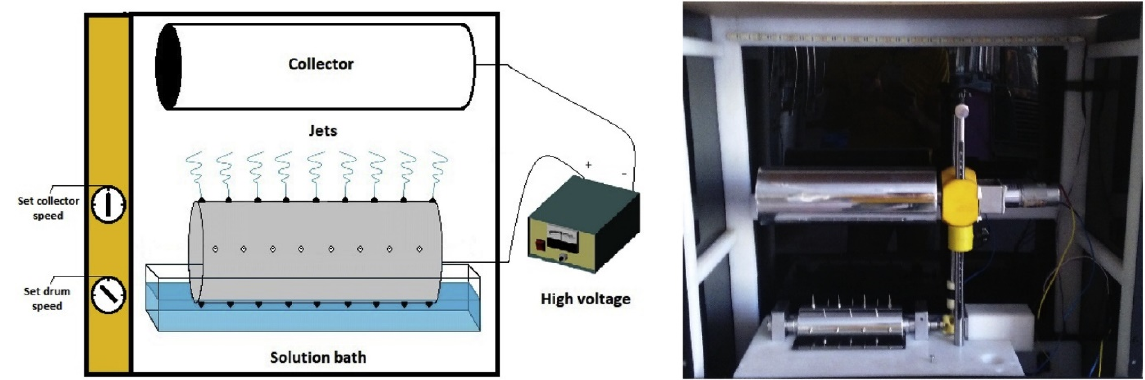
Figure 16. Schematic and image of nozzle-less electrospinning device (taken from [28]).